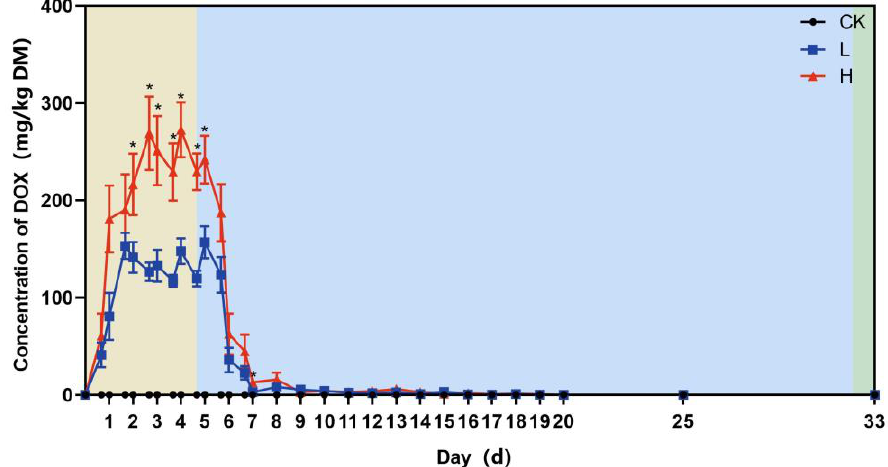
Figure 1. The concentration of doxycycline in pig feces. The bars represent the standard error. The * indicates that the concentration of doxycycline in group H is significantly different from it in group L ( p < 0.05). The medication period was defined as 0–4 days for 5 days in total (light yellow color), and the withdrawal period was defined as 5–32 days for 28 days in total (blue color). The 33rd day was the first day after the withdrawal period (green color).